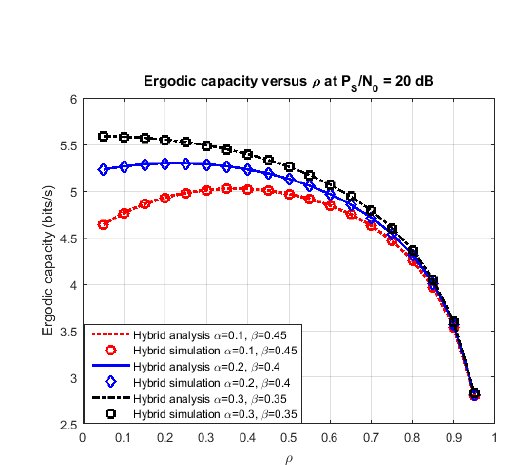
Fig. 8: Comparison of delay-limited and delay-tolerant modes.